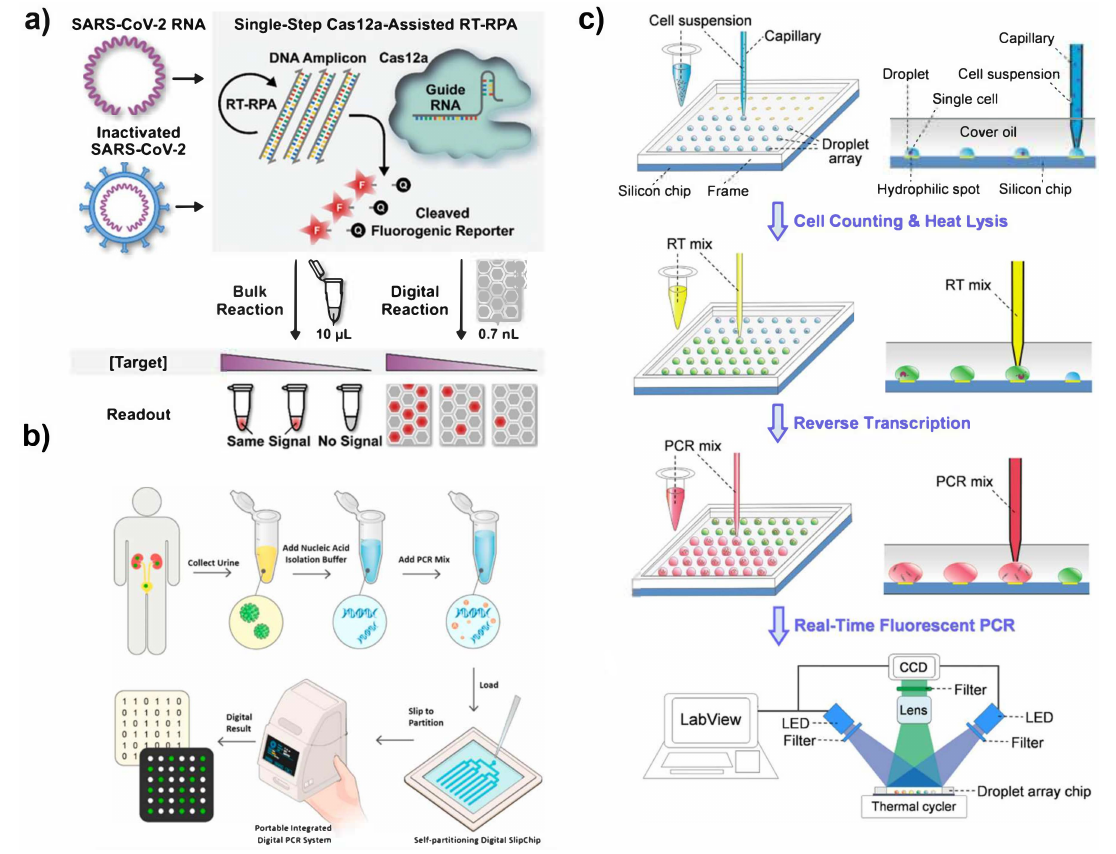
Figure 3. ( a ) CRISPR microwell array workflow. Reprinted with permission from Advanced Science [90] under Creative Commons https://creativecommons.org/licenses/by/4.0/ (accessed on 25 July 2022). ( b ) Workflow of SlipChip device for digital PCR. Reprinted from